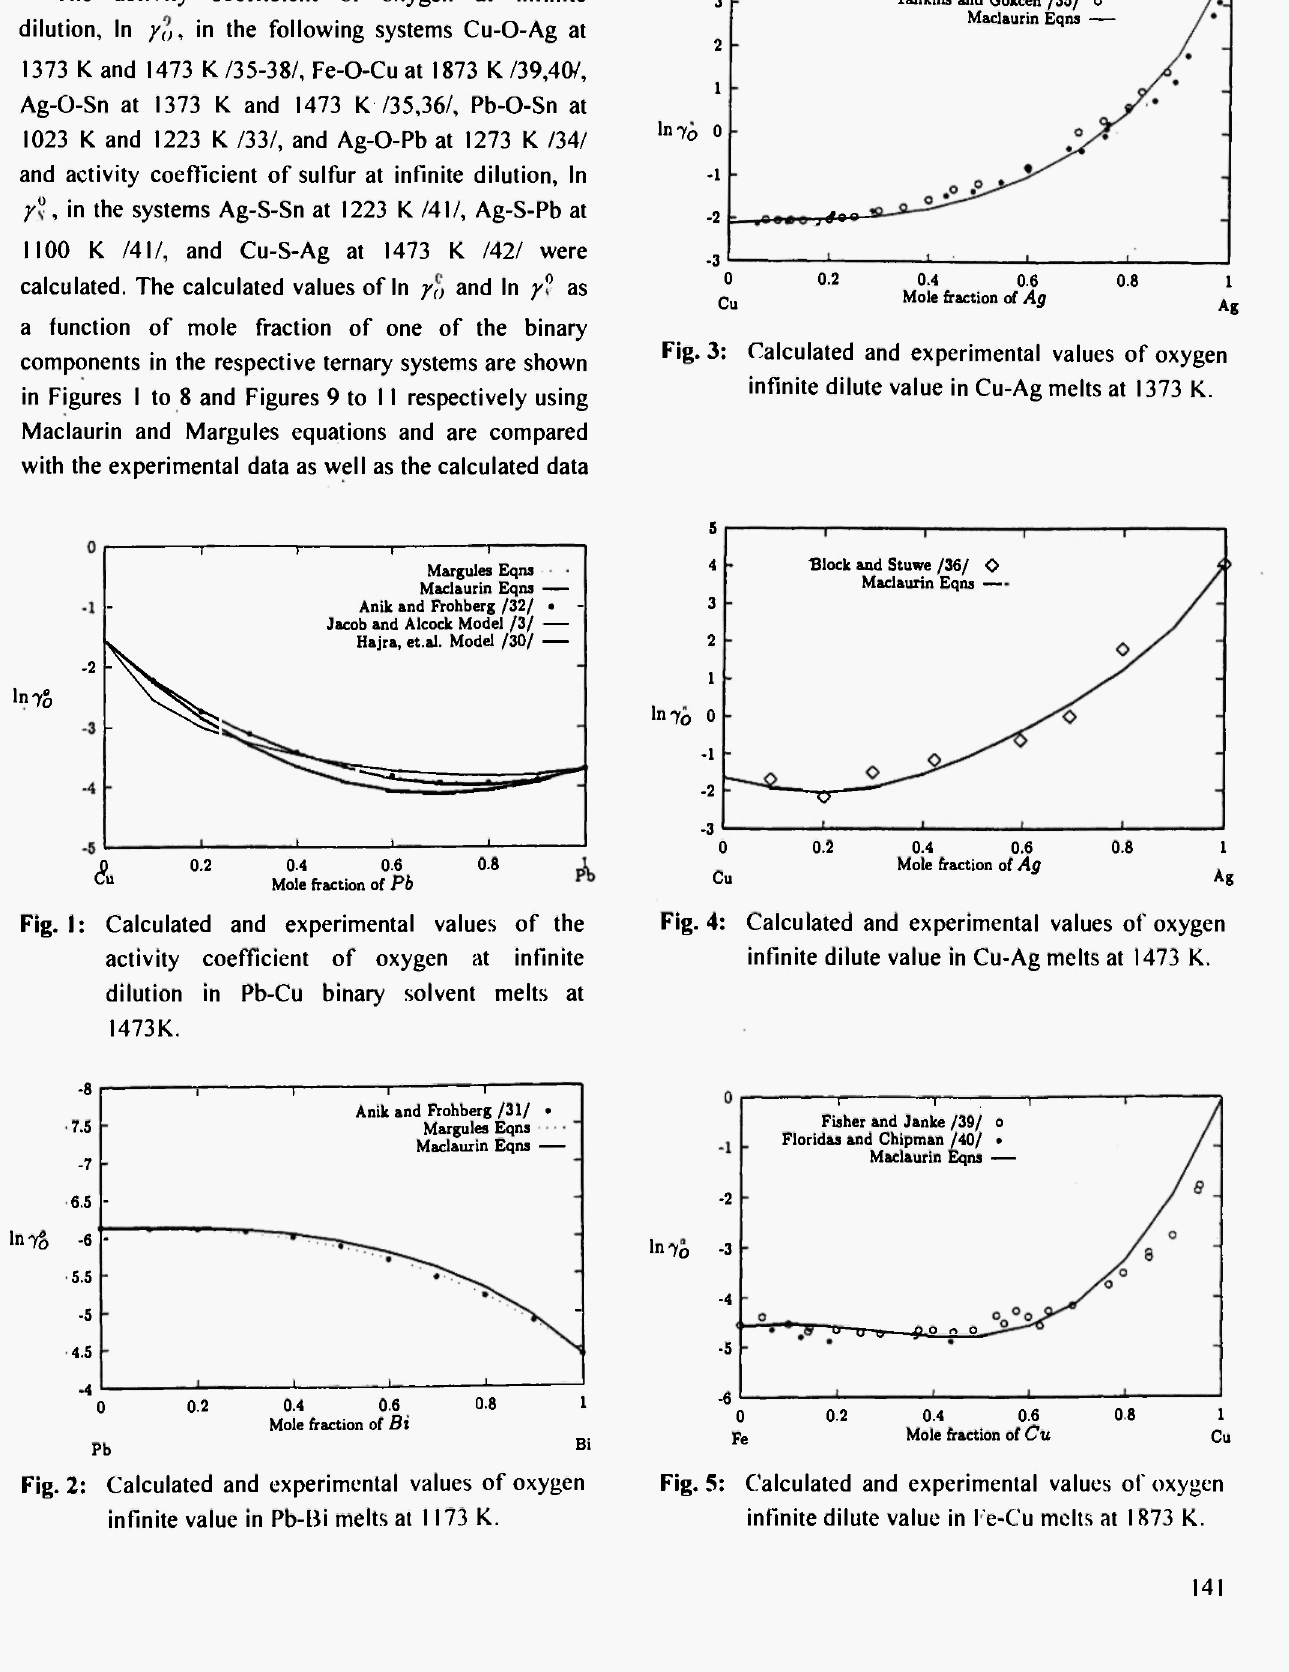
Fig. 5: Calculated and experimental values of oxygen infinite dilute value in I'e-Cu melts at 1873